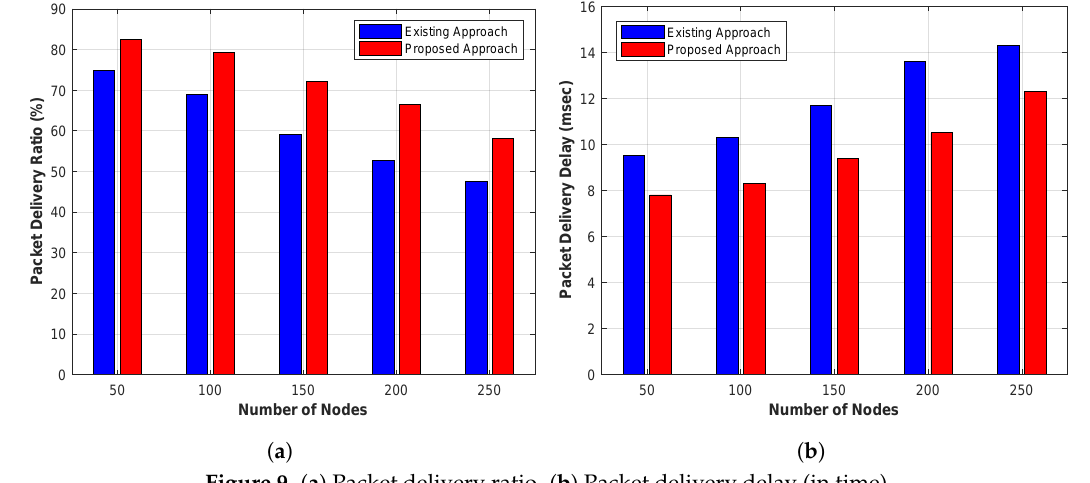
Figure 9. ( a ) Packet delivery ratio. ( b ) Packet delivery delay (in